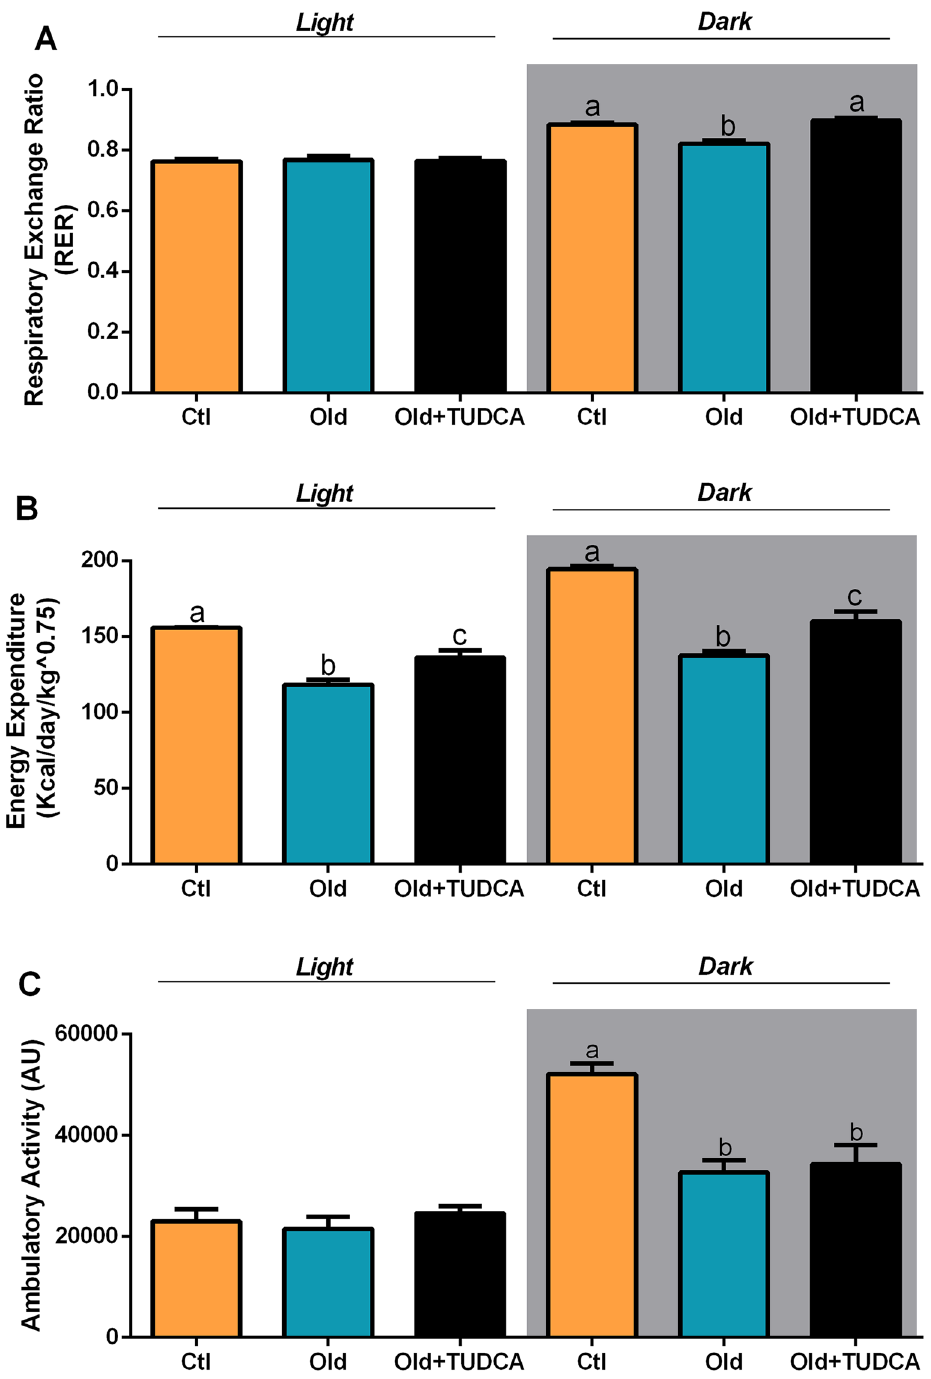
Figure 5. Effects of TUDCA treatment upon RER, EE, and ambulatory activity. Respiratory exchange ratio (RER) ( A ), energy expenditure (EE) ( B ), and ambulatory activity ( C ) average during light (7 a.m. to 6:59 p.m.) and dark (7 p.m. to 6:59 a.m.) cycles. Data are presented as mean ± SEM (n = 6–8). Statistical analysis was performed using the one-way ANOVA test, followed by Tukey post-hoc-test. Letters shared in common between groups indicate no significant difference. Different letters (a, b, and c) indicate statistical difference between groups (P ≤